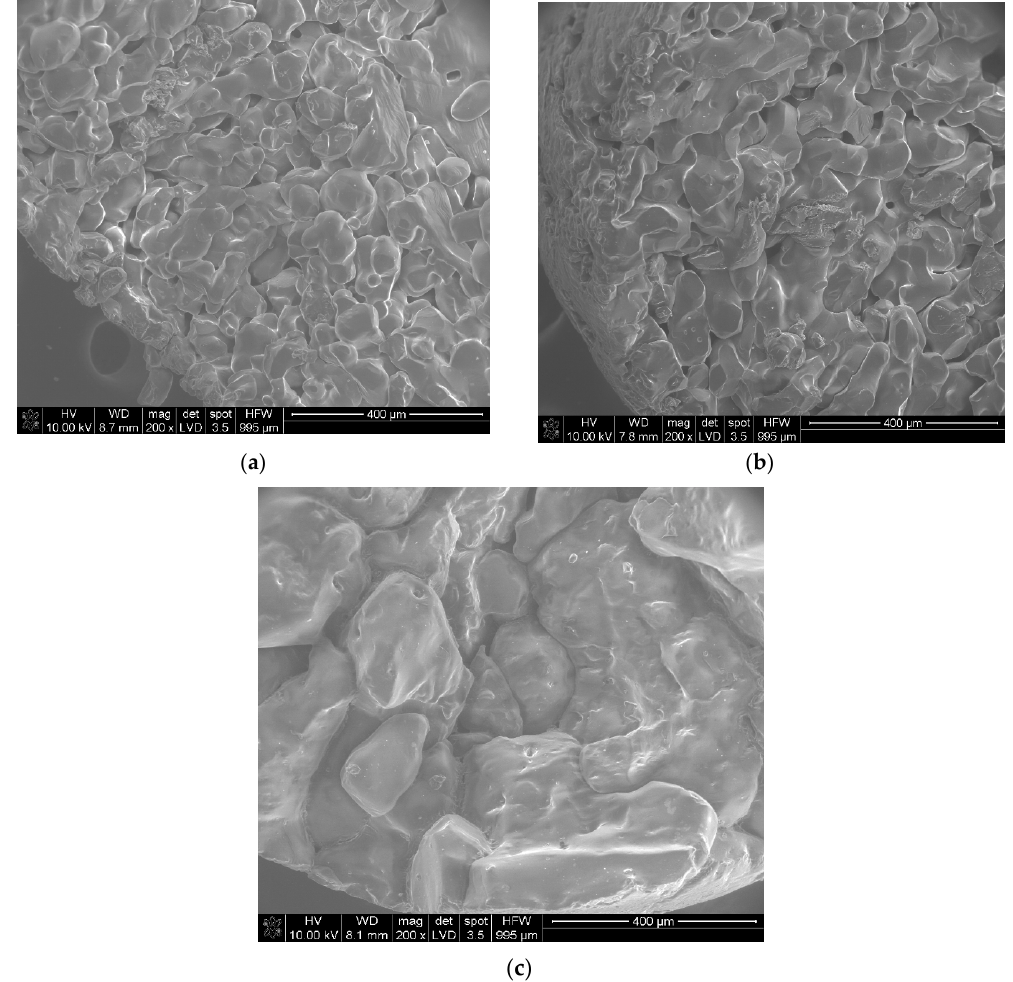
Figure 2. SEM images of cross-sectioned prill surface at a magnification of 200 × : ( a ) AN-PP8; ( b ) AN-PP7; ( c ) AN-F.